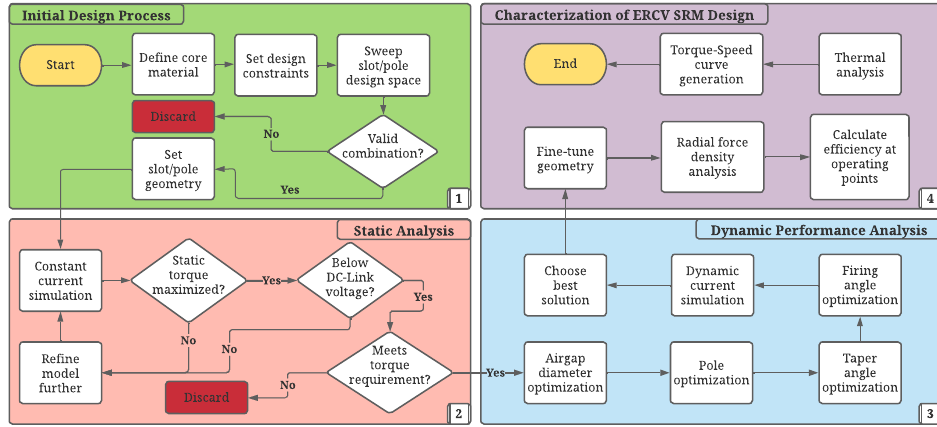
Figure 2. SRM proposed design process.